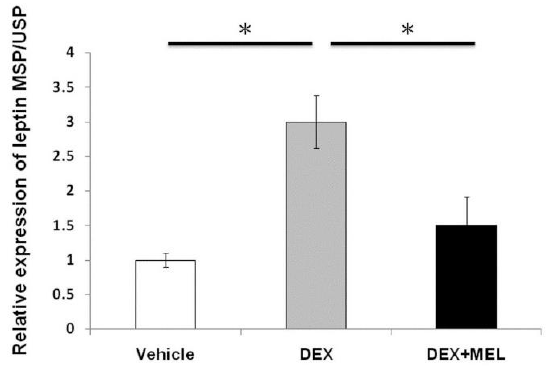
Figure 3. Expression of leptin methylation. Leptin methylation-specific PCR/unmethylation-specific PCR (MSP/USP) showed that the DEX group had increased levels of leptin methylation, with those levels decreasing after melatonin treatment. All the results represent the mean ± standard error of six animals, * p < 0.05 when comparing the DEX group with vehicle group or the DEX+MEL group with the DEX group. The letters represent different groups. DEX, prenatal dexamethasone; DEX+MEL, melatonin treatment after prenatal dexamethasone.